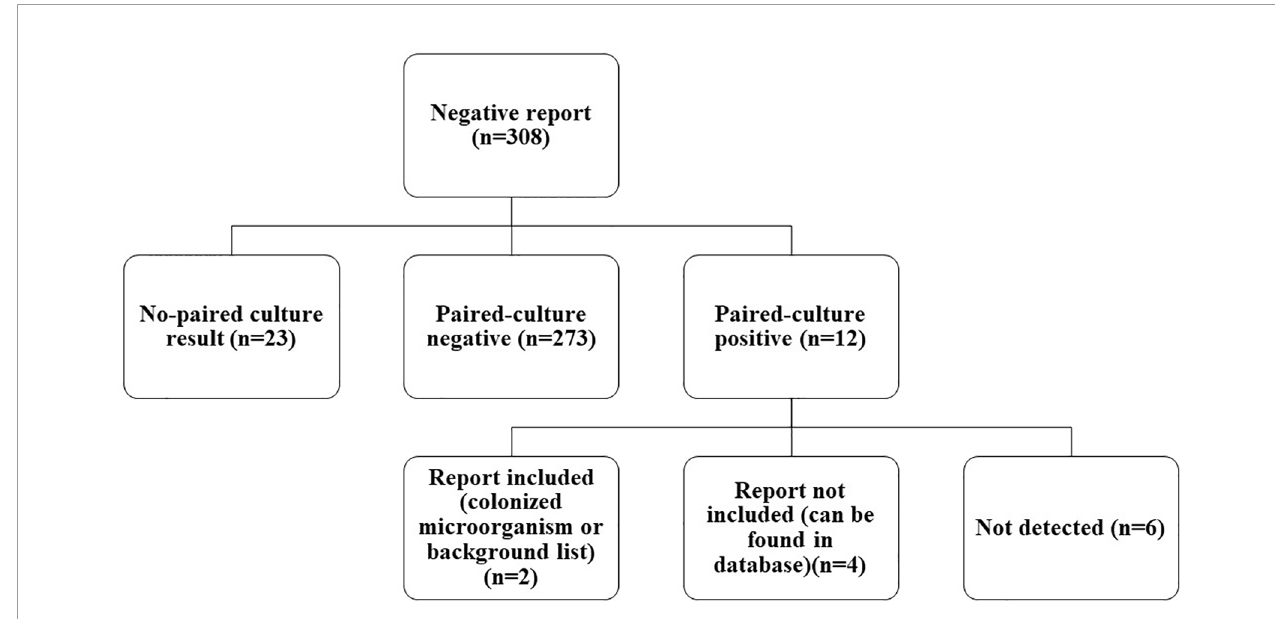
FIGURE 3 | Classi fi cation of negative mNGS cases. In total, 308 negative mNGS cases were divided into no paired-culture result, paired-culture negative, and paired-culture positive. Twelve paired-culture positive cases were further divided into report included, report not included, and not detected. mNGS, metagenomics next-generation sequencing.